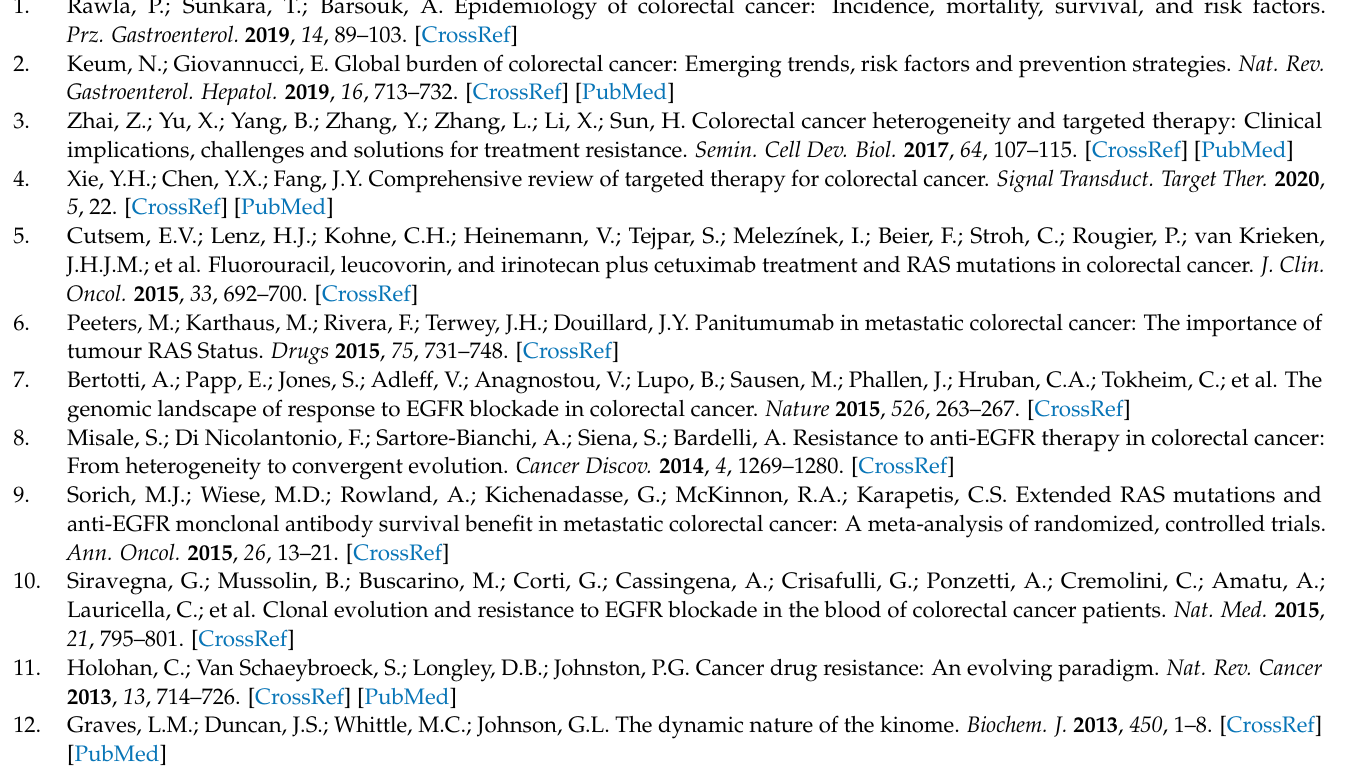
assay; Table S2: Clinical data; Table S3: List of primer sequences used for qRT-PCR and TaqMan assays ID; Table S4: Patient characteristics in 6 cohorts analyzed; Table S5: Clinical characteristics of YKL-40 high and YKL-40 low patients in cohorts 1 to 6; Table S6: Univariate and multivariate analyses of factors affecting DFS in stage I–III patients (cohort 1) and RFS in stage I-IV patients (cohort 4); Table S7: Univariate and multivariate analyses of factors affecting PFS in patients who received cetuximab monotherapy (cohort